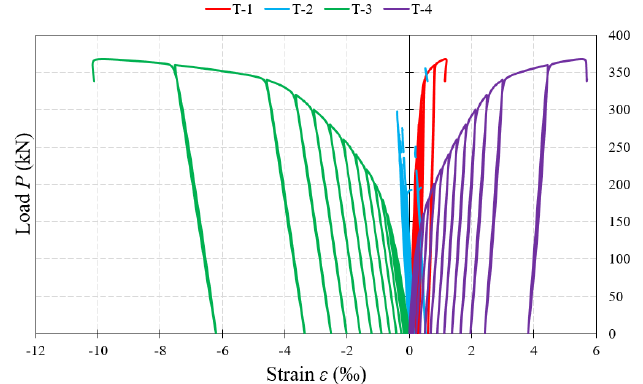
Figure 17. Load–strain relationship in the measurement points (T-2, T-3) located on the web surface at the support.